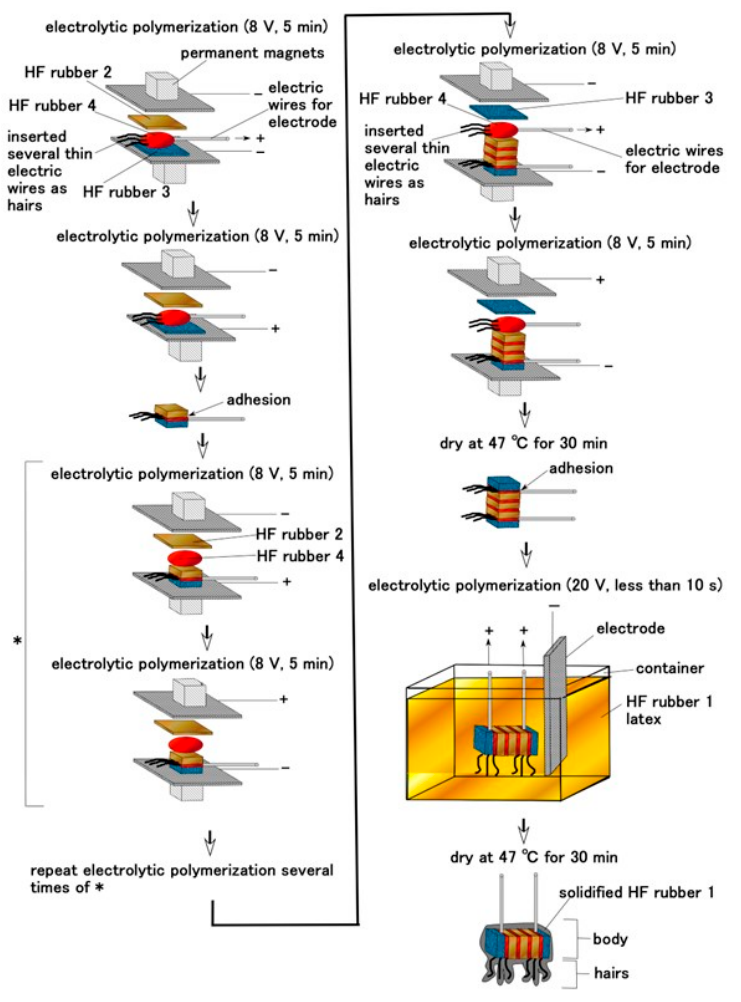
Figure 3. Fabrication process of layered-type Pacinian corpuscles for gustatory receptor.